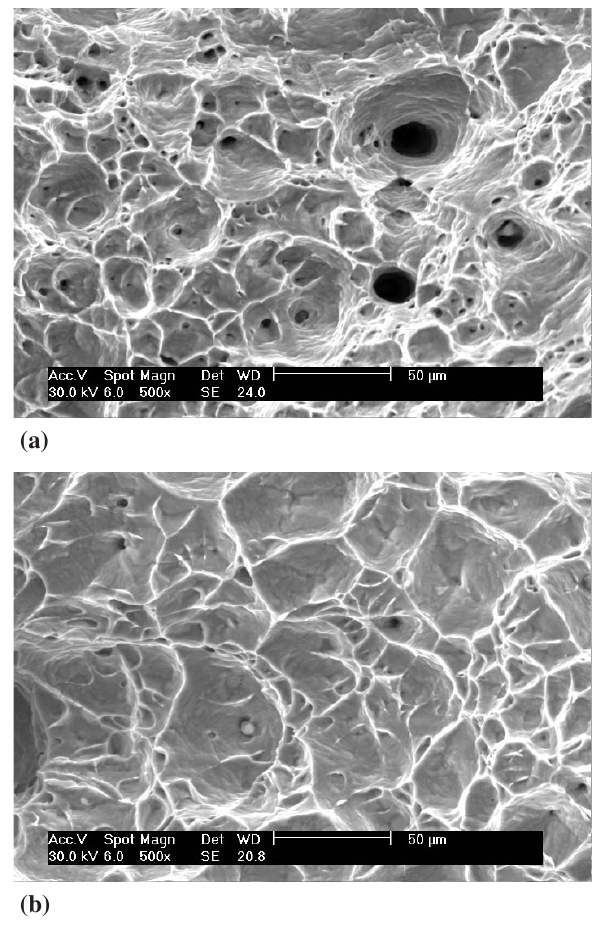
Figure 9. SEM fractographs of 7N specimens tested at 823 K (a) Smooth and (b) Notched.